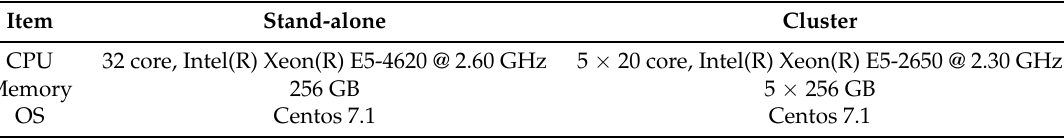
Table 2. Hardware environment.